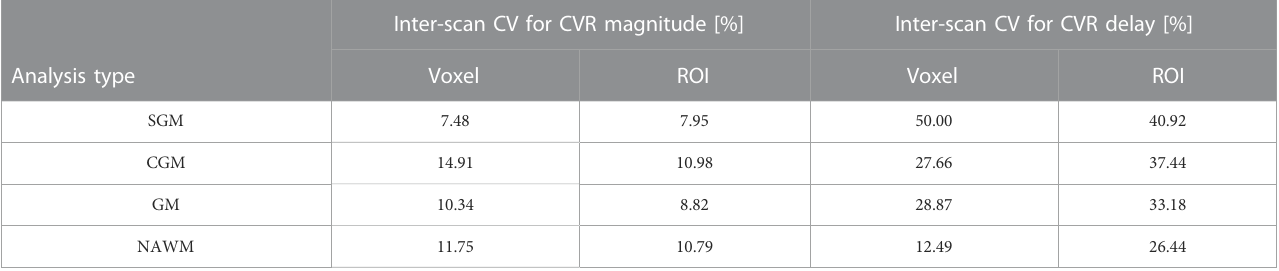
TABLE 2 Inter-scan coef fi cients of variation for CVR magnitude and delay in SGM, CGM, GM, and NAWM as a function of the analysis type. Inter-scan CV for CVR magnitude